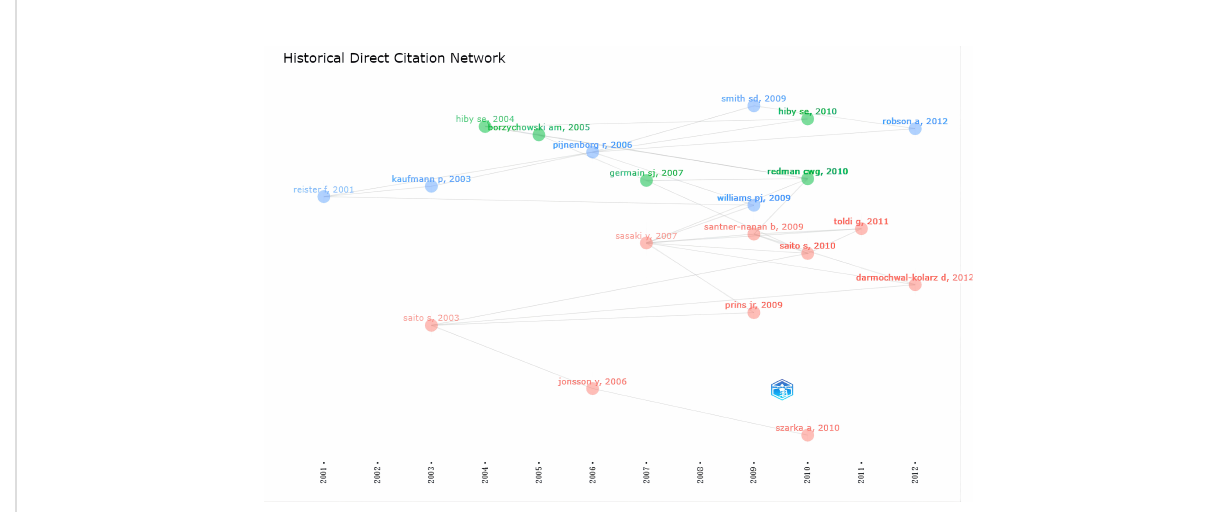
FIGURE 6 Historiograph of HDP and immune cells